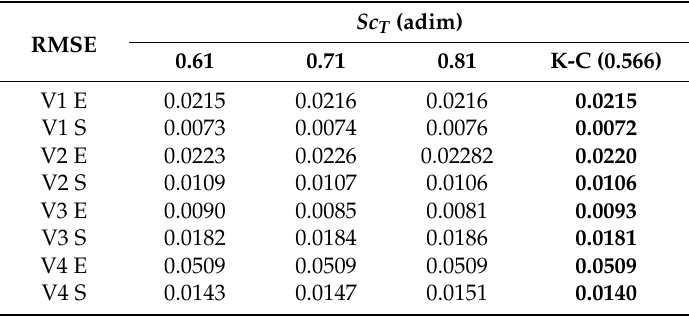
Table 5. Approximation of RTD curves varying Sc T values.